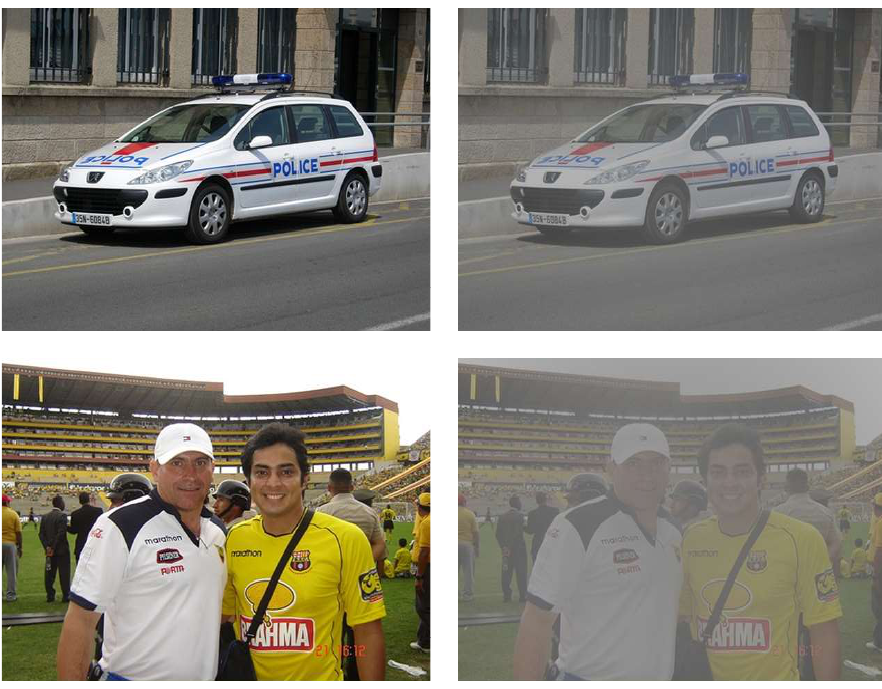
Figure 9. Example of VOC_hazy_test dataset.